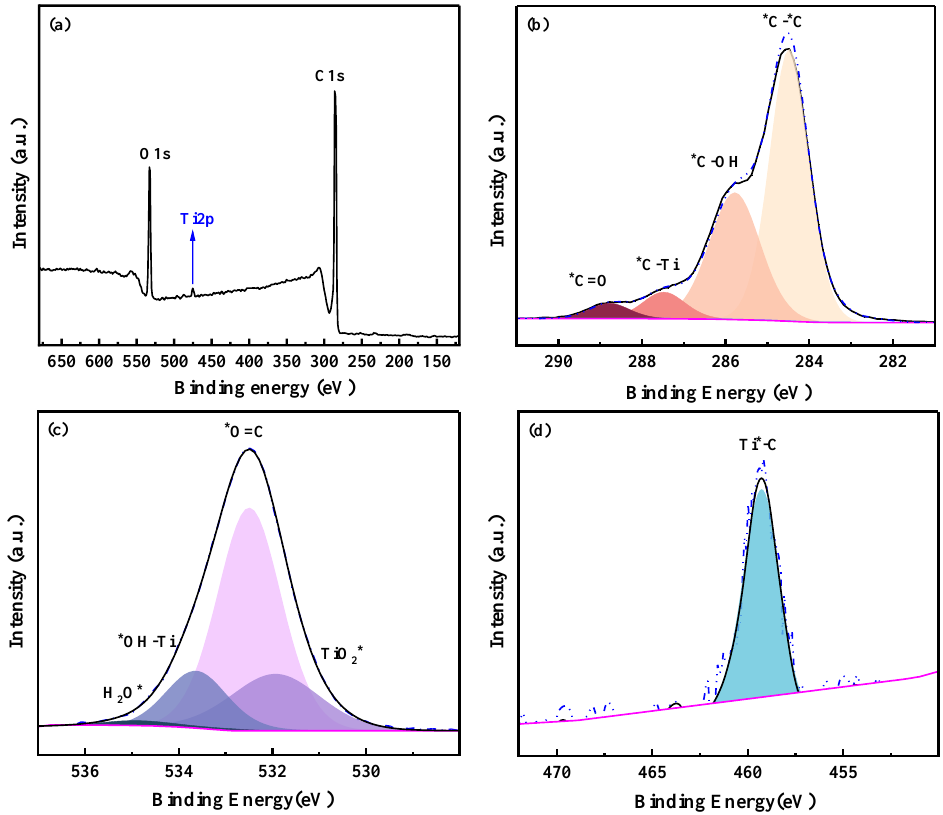
Figure 6. ( a ) XPS spectra and XPS peak resolutions of ( b ) C1s, ( c ) O1s, ( d ) Ti2p of the top-surface of the PGM-0 membrane. * represents the elements with partial peaks. Table 2. XPS binding energy and relative content of each element (C, O, S and Ti) and chemical structures originated from the peak resolution.